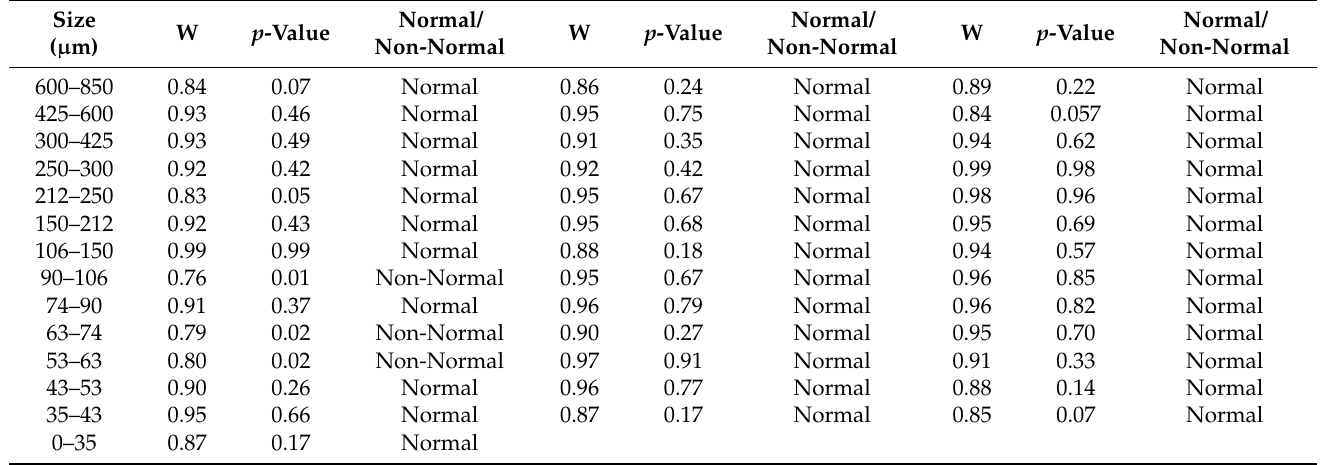
Table A10. Shapiro–Wilk test for the 12 min grinding test.